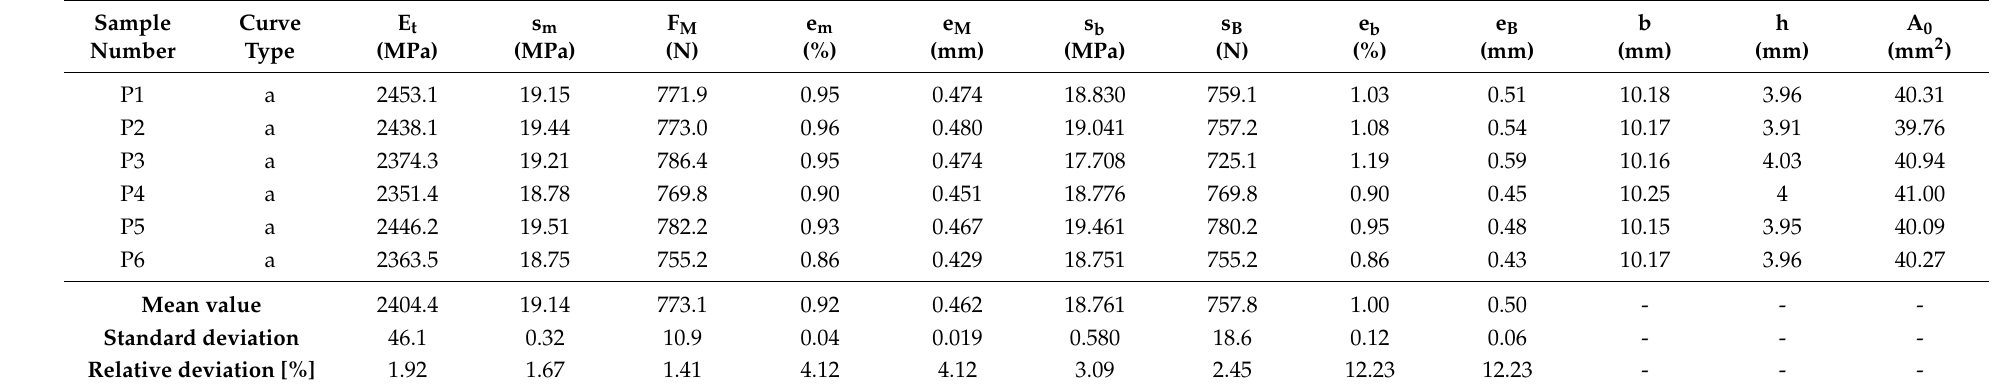
Table A36. Results of the tensile tests of P_C,PS.